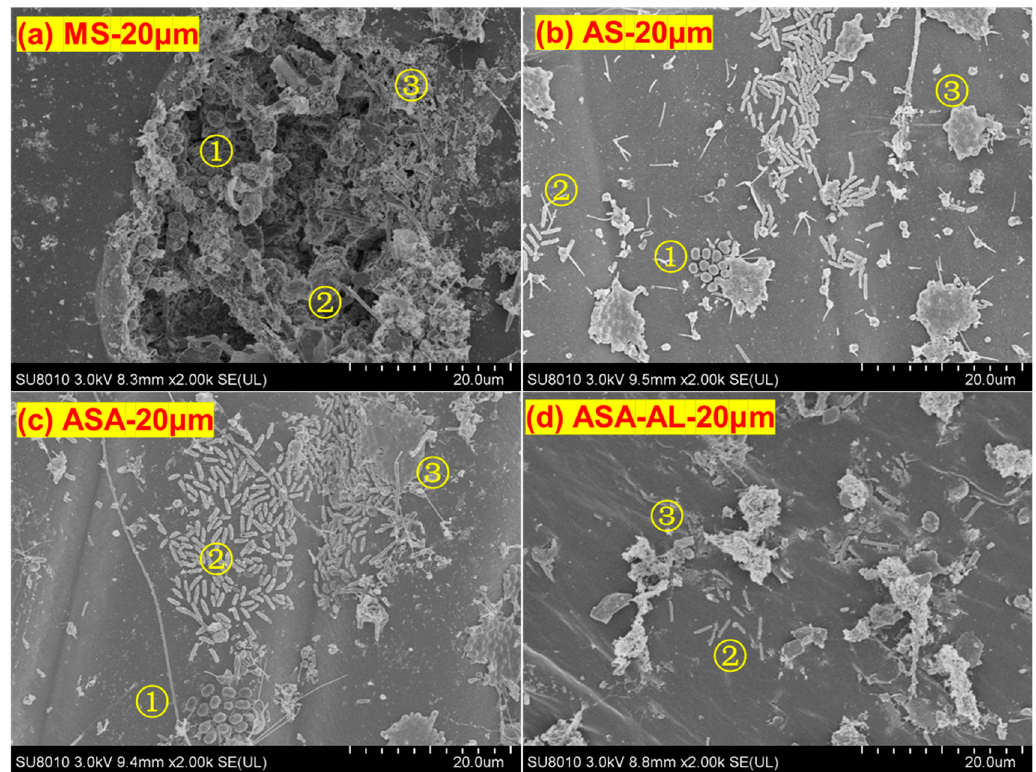
Figure 9. Scanning Electron Microscopy (SEM) images ( a – d ) of biofilms attached to V. natans leaves.